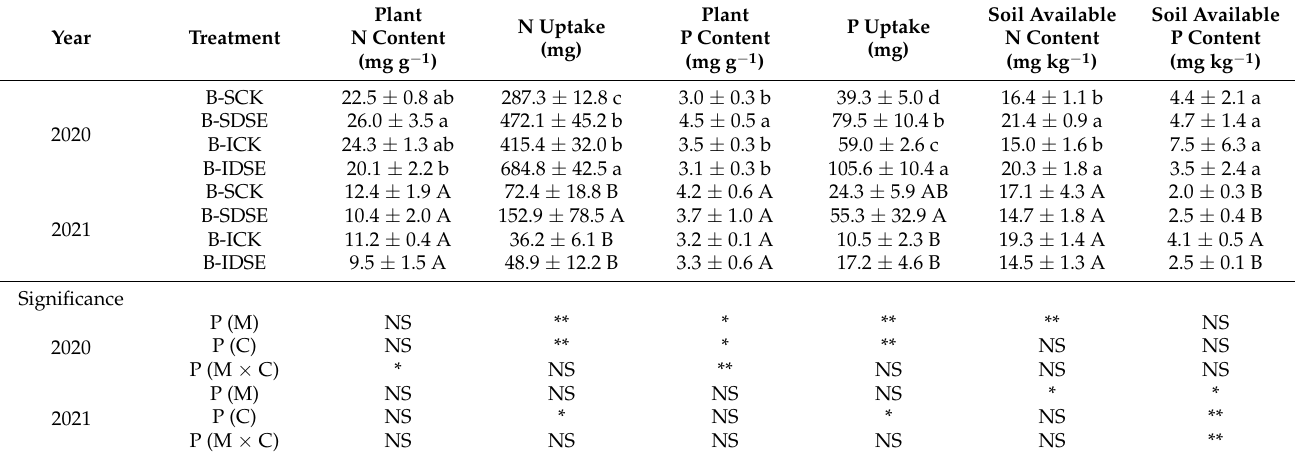
Table 3. Effects of the different treatments on nutrient uptake by